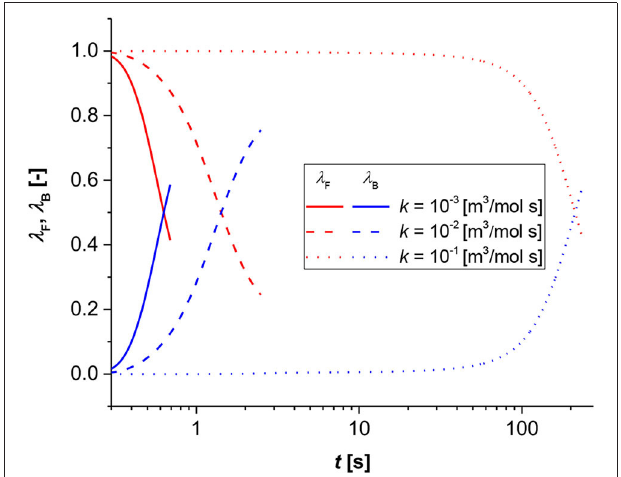
FIGURE 6 | Contribution analysis results for bulk (blue lines) and film (red lines). Simulation conditions D i = 1 × 10 − 9 [m 2 /s], R 0 = 1 × 10 − 3 [m], k = 1 × 10 − 3 [m 3 /(mol